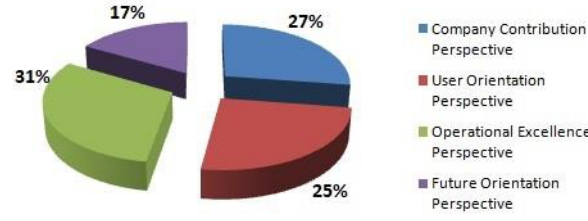
Figure 11: Precentage Results From Each